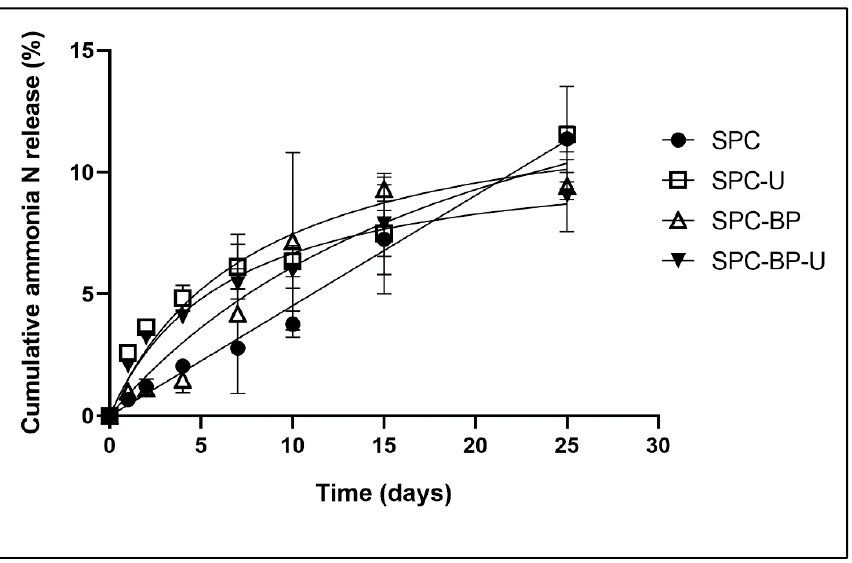
Figure 9. Percentage of initial N released in solution as ammonia.